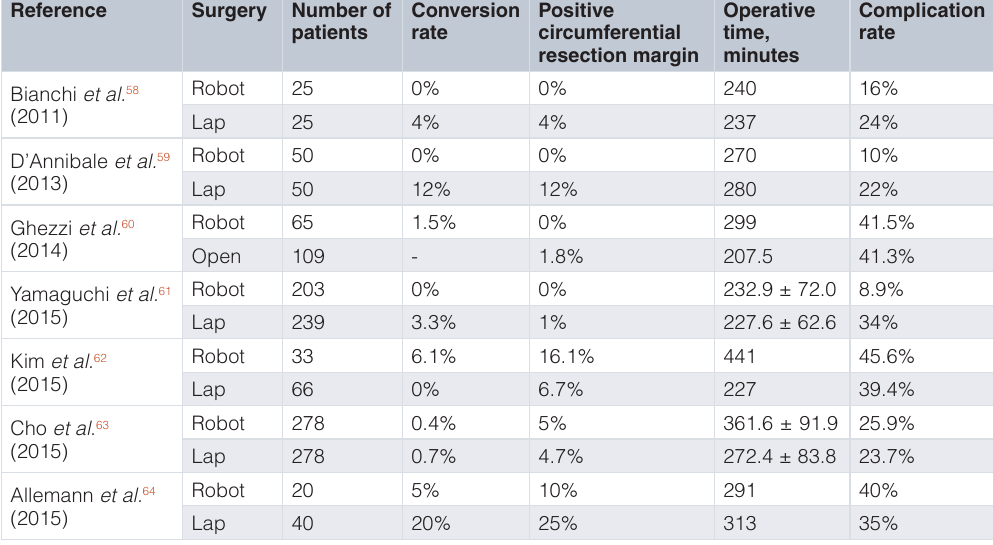
Table 1. Recent studies on robotic versus laparoscopic or open rectal cancer excision